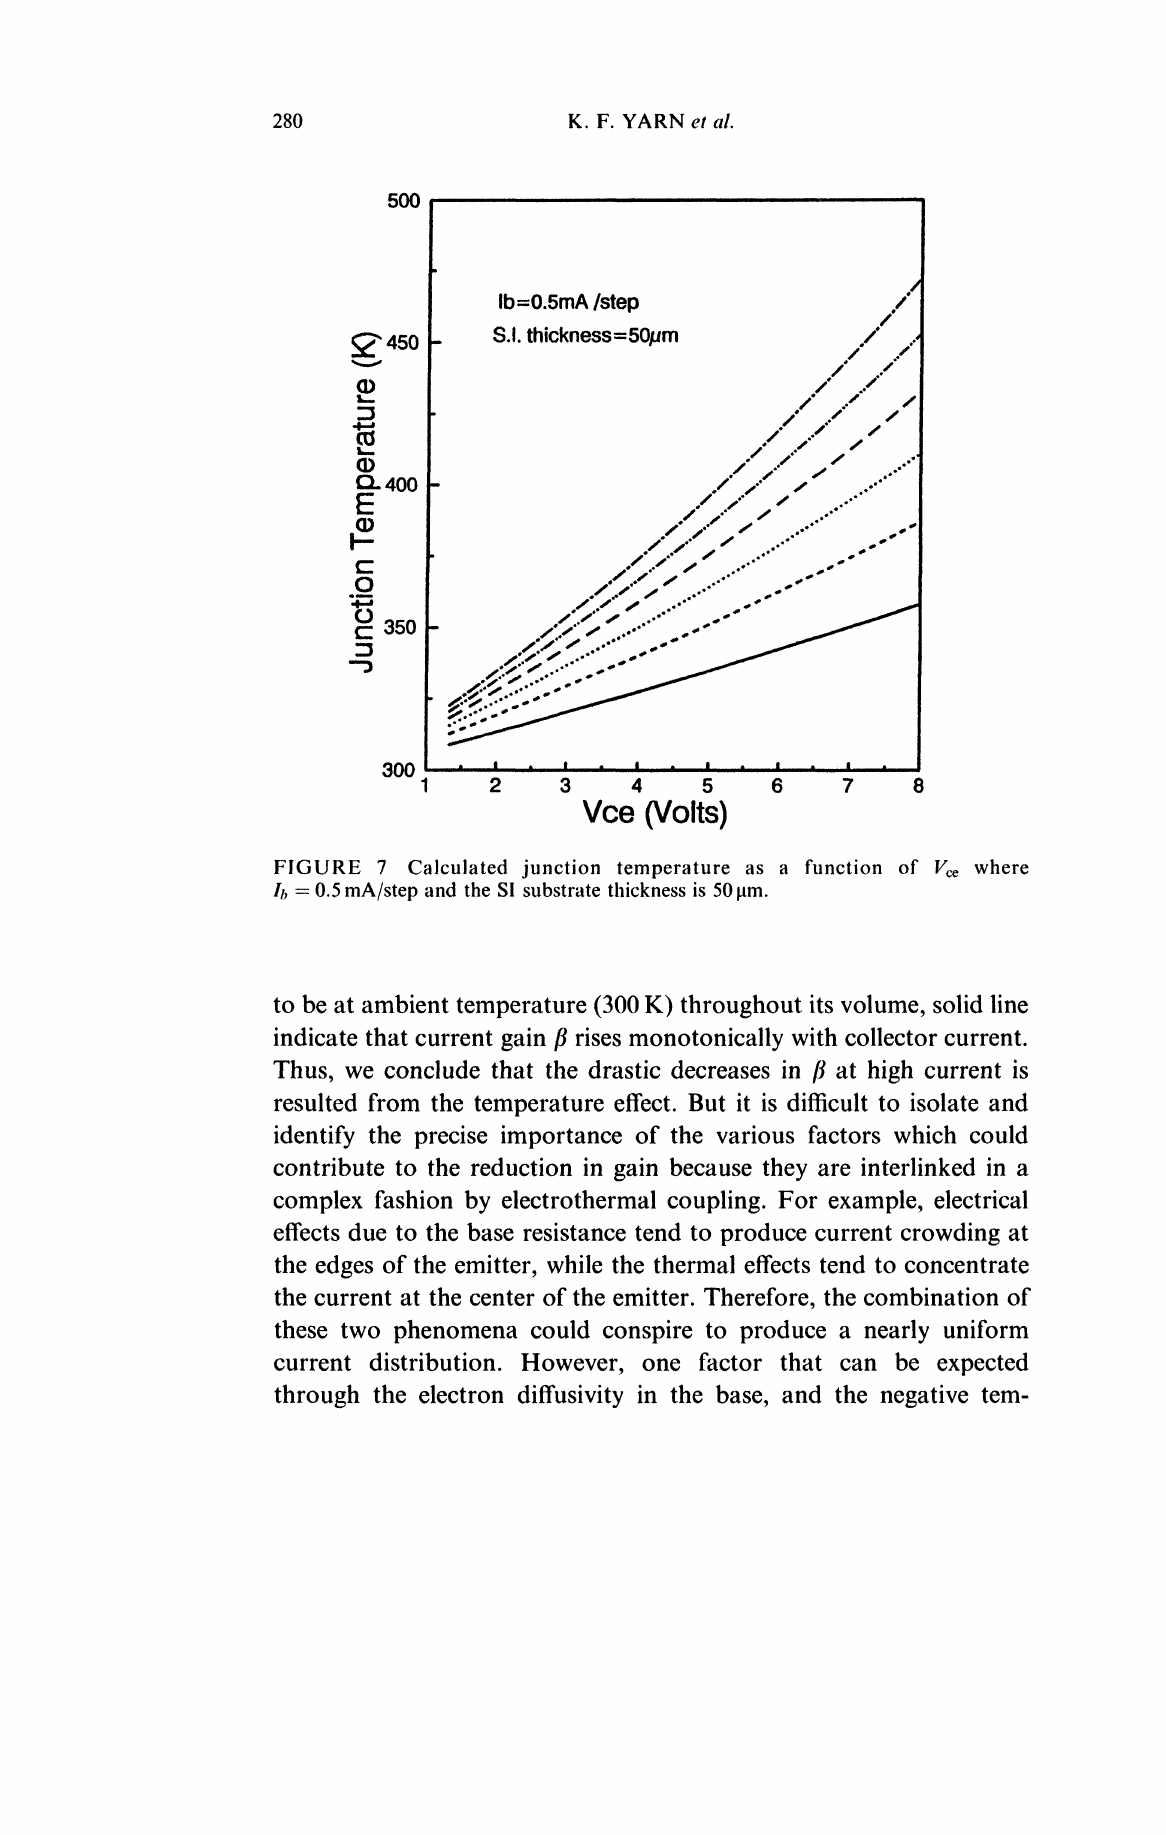
FIGURE 7 Calculated junction temperature as a function of Vce where It, -0.5 mA/step and the Sl substrate thickness is 50pm.